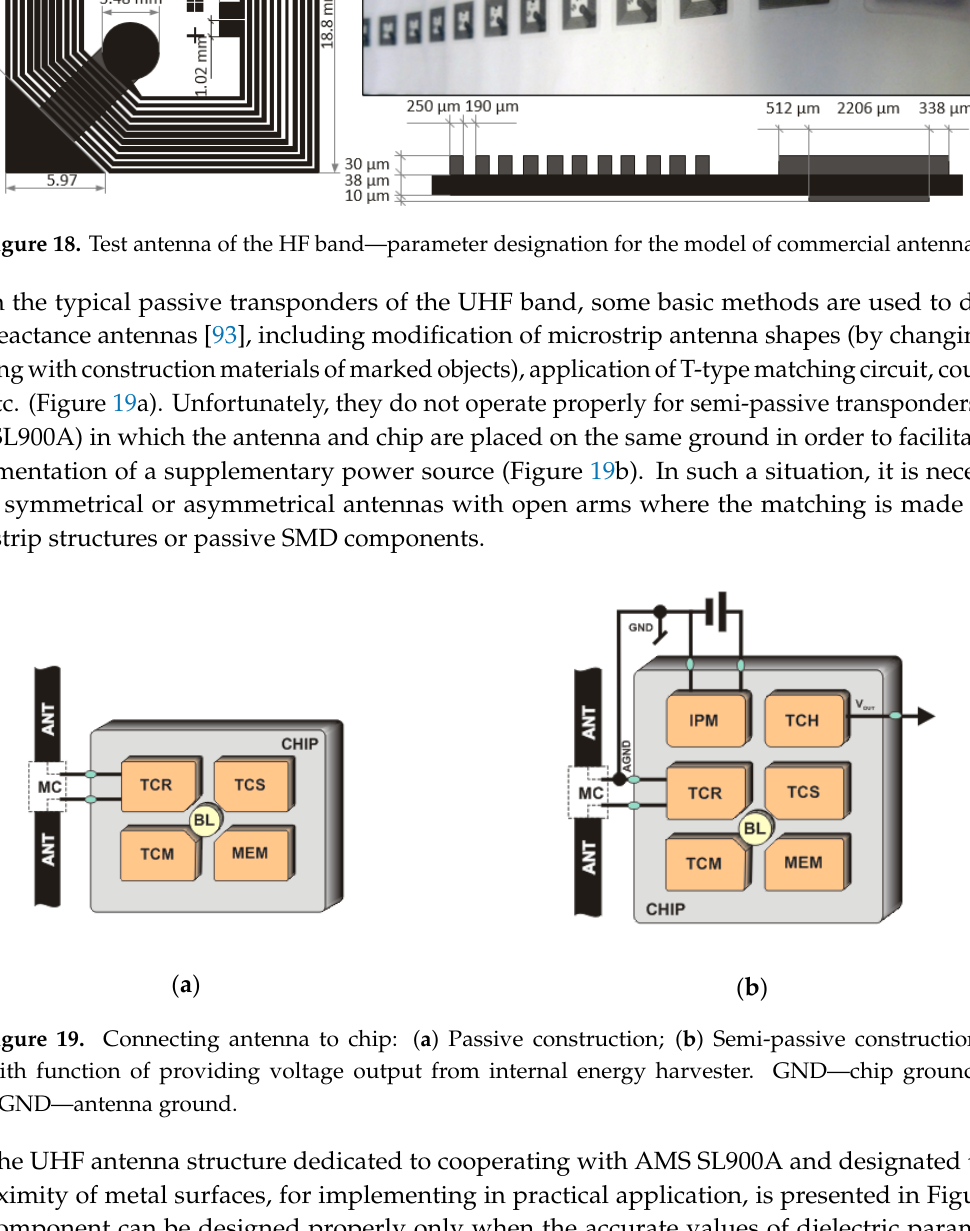
Figure 20. UHF antenna dedicated to AMS SL900A chip. 1—radiator; 2—ground; 3—chip; 4—connector. Taking into account the specific requirements of target application, the antennas presented in Figure 21 were also designed for the use with a passive/semi-passive AMS SL900A chip. The satisfactory convergence is achieved in terms of practical usability. However, small differences are noticeable on the determined courses Z TA ( f ) (Figure 22). On the basis of the acquired data analysis, feedback information about the technological process accuracy as well as verification of numerical calculations, it can be indicated that visible discrepancies are caused by not sufficient resolution of a CNC machine on which the pattern of conductive paths is made. The fact that substrate dielectric parameters (relative permittivity and loss tangent) are assumed to be fixed in the frequency domain have also significant impact on the obtained results—this assumption of constant values is not consistent with reality and it is characterized in [29].